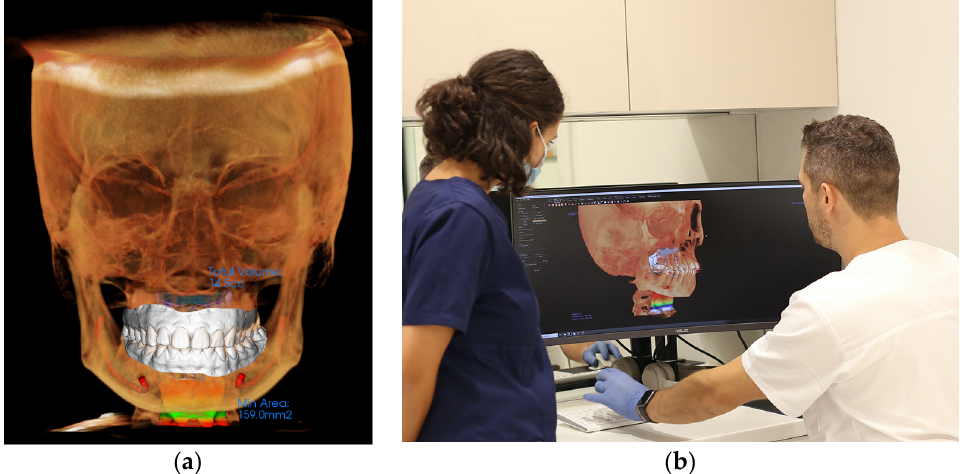
Figure 4. ( a ) Skull model with overlapping intraoral teeth scan, passage of the airways and transition of the inferior alveolar nerve that also allowed accurately positioned placement of STL or PLY models of intraoral scanning, all managed within the workflow of trained dental nurse; ( b ) explaining the analysis to another doctor, to dental assistants or patient.